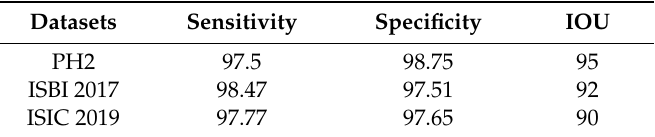
Table 6. Skin lesion location detection performance (%) analysis of